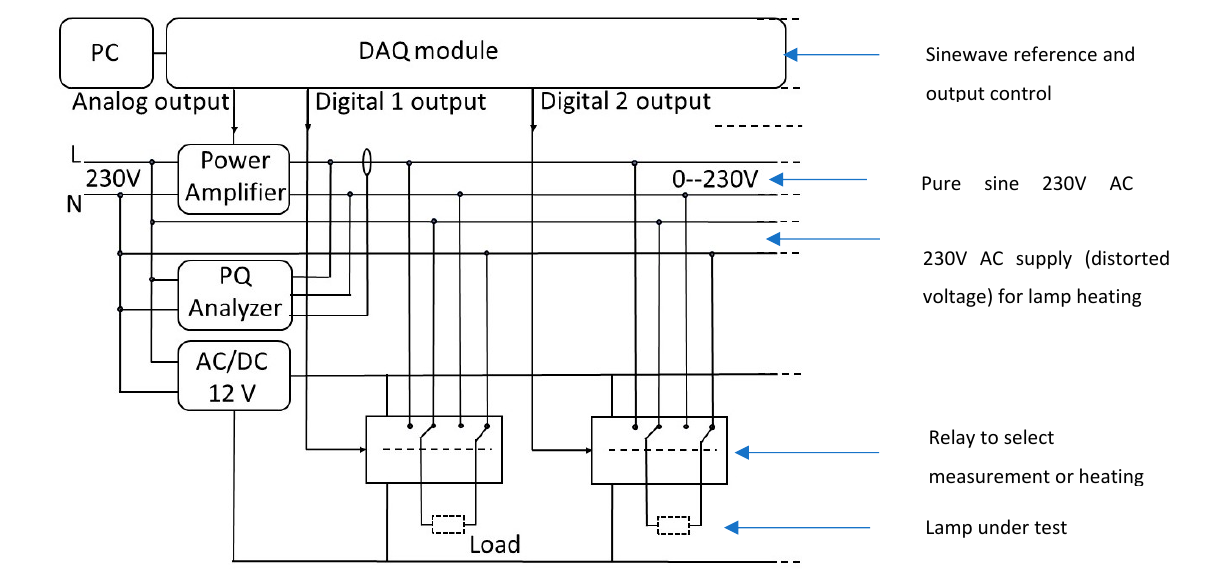
Figure 2. Measurement setup.